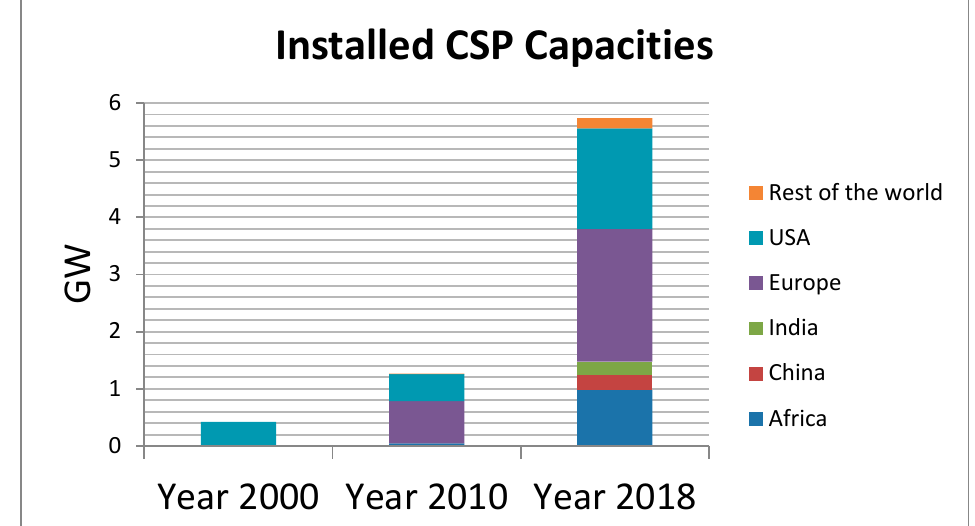
Figure 5. Installed CSP capacities for selected countries and regions [26].